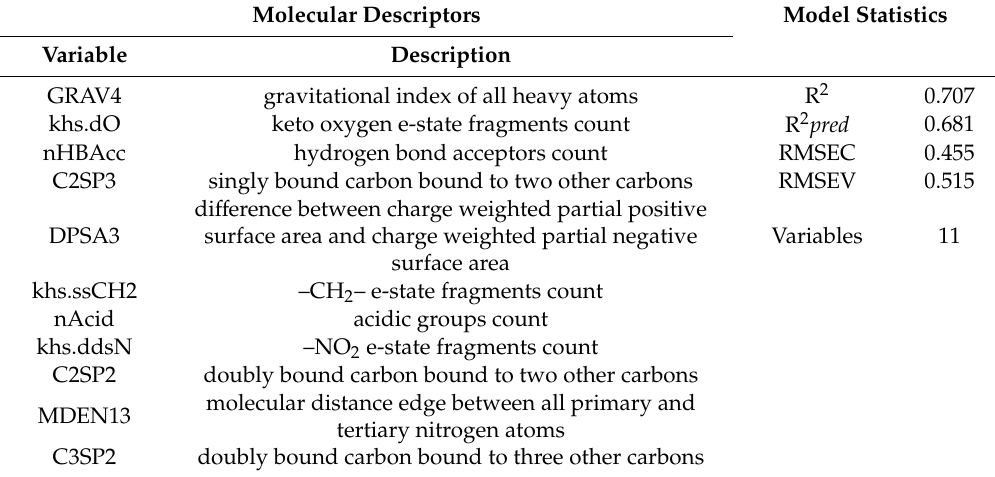
Table 5. Multiple linear regressions model (MLR) quantitative structure-activity relationship (QSAR) model descriptors and evaluation metrics.